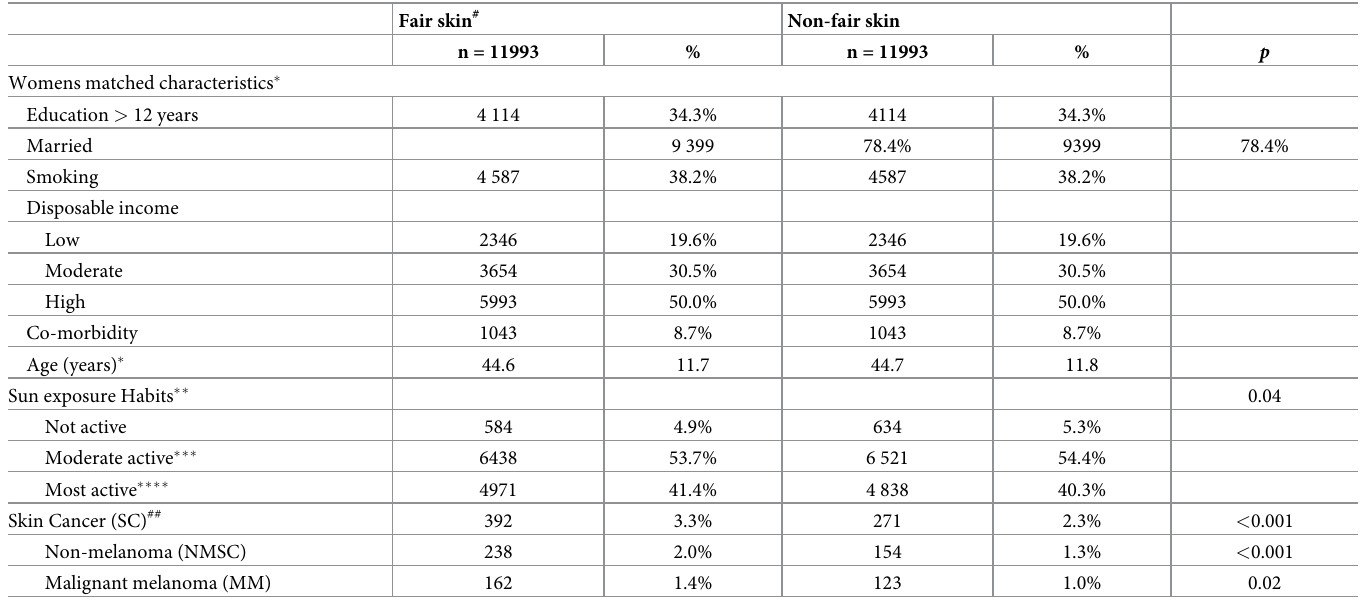
Table 1. Characteristics of women included in the nested matched case control study, matched on six variables at inception of study. Fair skin